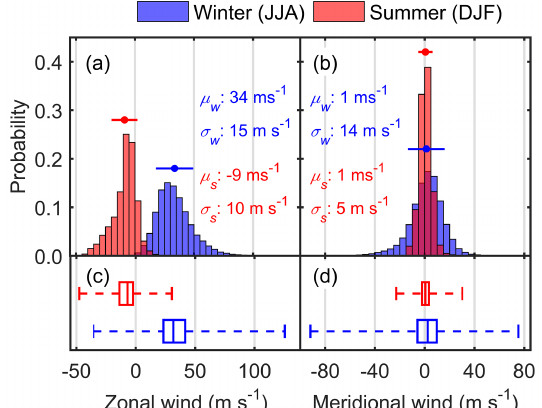
Figure 2. Histograms of (a) zonal and (b) meridional winds over the pressure range 0.1–25hPa ( ∼ 64–25km) in winter (JJA, blue) and summer (DJF, red) from 6-hourly ERA-interim data for 2009–2014 at grid-point 75.5 ◦ S, 26.5 ◦ W. The horizontal error bars show the mean winds ( µ w , µ s ) and standard deviations ( σ w , σ s ) for winter (JJA) and summer (DJF) respectively. The corresponding boxplots of the (c) zonal and (d) meridional wind data indicate the minima, lower quartile (25th percentile), median, upper quartile (75th per- centile), and maxima wind speeds. + ve zonal winds are eastwards and + ve meridional winds are